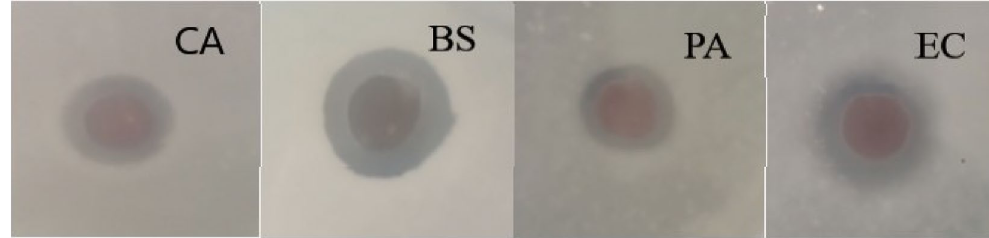
Figure 13. Inhibition of nanocomposite against C. albicans (Ca), B. subtili (Bs), and P. aeruginosa (Pa) , E. coli (Ec).